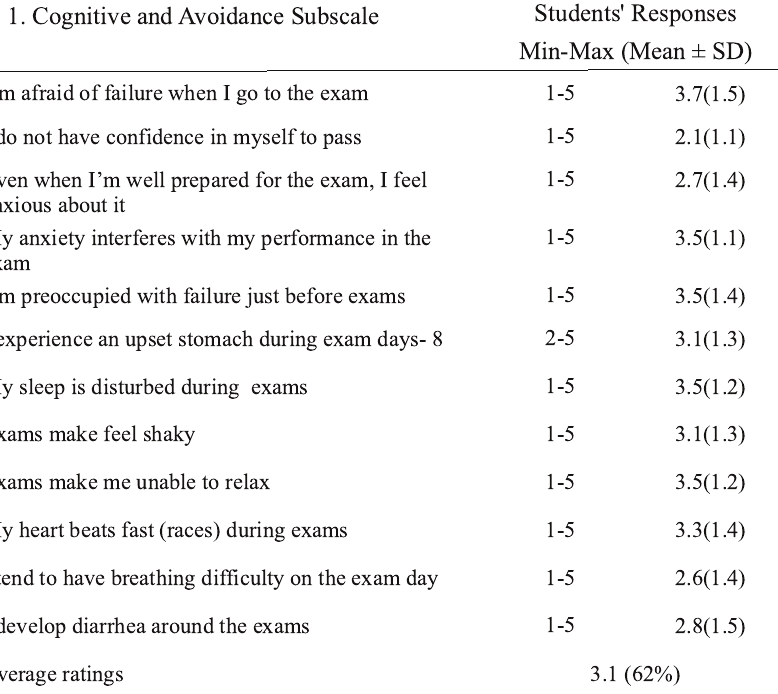
Students’ratings ofthe examination anxiety scale 1. Cognitive and Avoidance